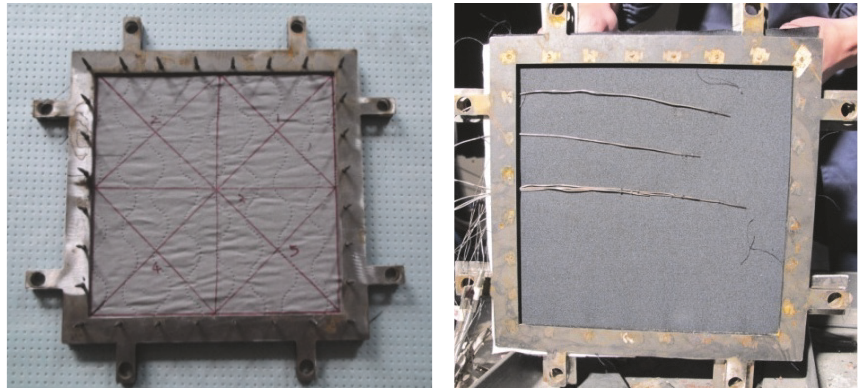
Figure 2: Thermocouples and sample